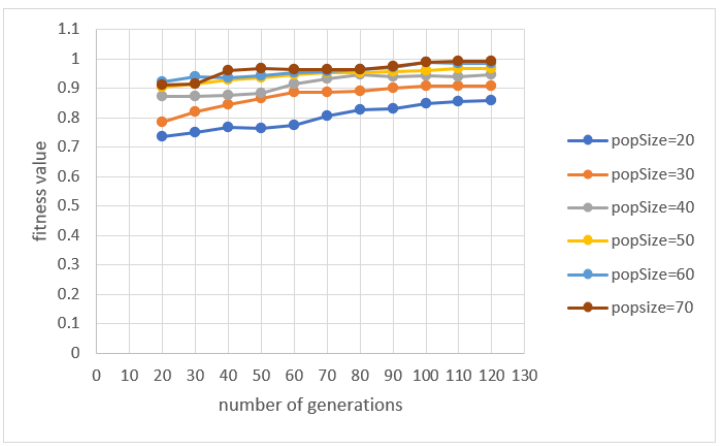
Figure 12. The average fitness variation when generations number is changed, and population size is constant.